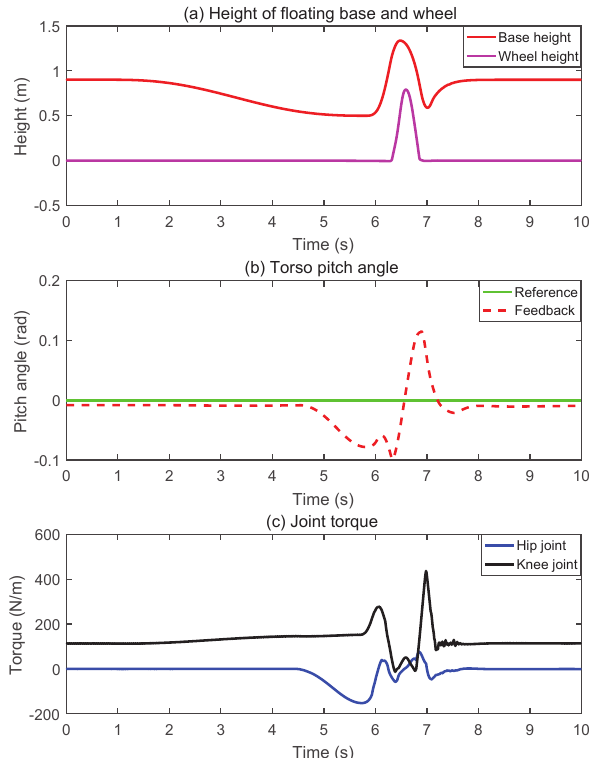
Figure 12. The simulation results of jumping. ( a ) Trajectories of the floating base and wheels. ( b ) The measurement of the torso pitch angle. ( c ) The profile of the joint